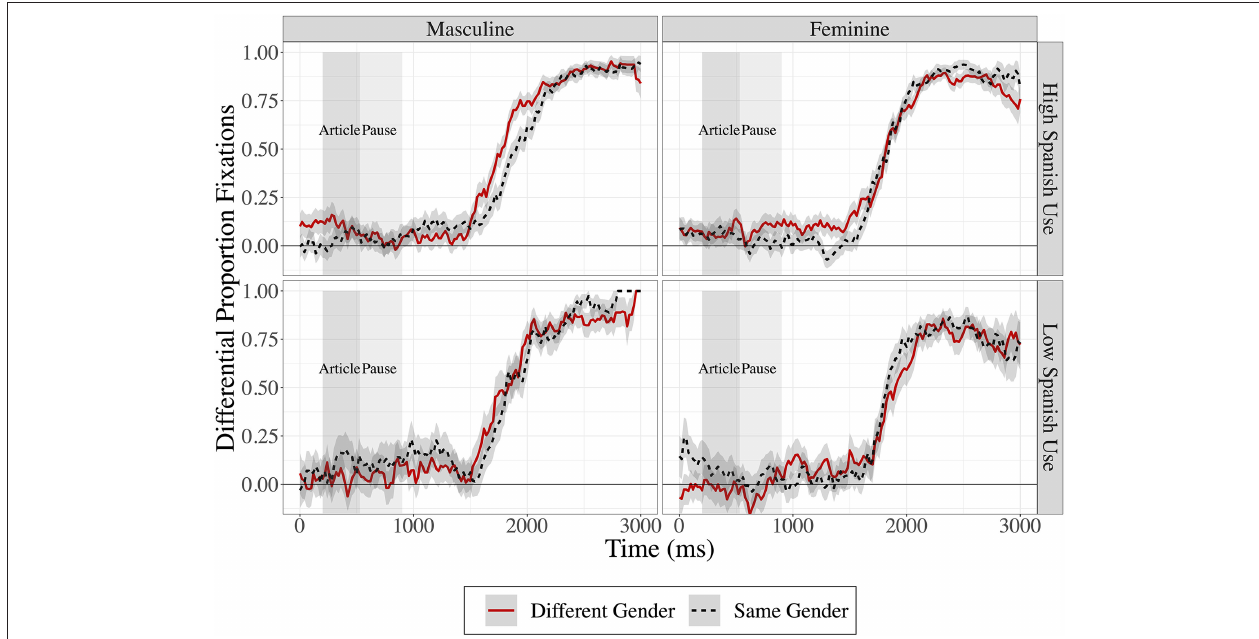
FIGURE 3 | Differential proportion fixations to target, with fixations in the different-gender condition in solid red lines and fixations in the same-gender condition in dashed black lines. Masculine targets are presented in the left panel and feminine targets are presented in the right panel. Participants with ≥ 50% Spanish Use are shown in the top row, and participants with < 50% Spanish Use are presented in the bottom row. Time in milliseconds is presented on the x-axis and differential proportion of fixations to target is presented on the y-axis. The shaded regions represent ± 1 standard error of the mean.